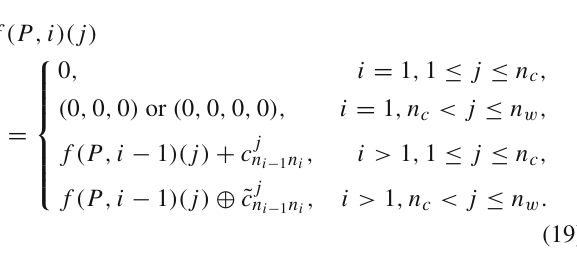
Table 1 The notations in the RSA and their meanings Notations